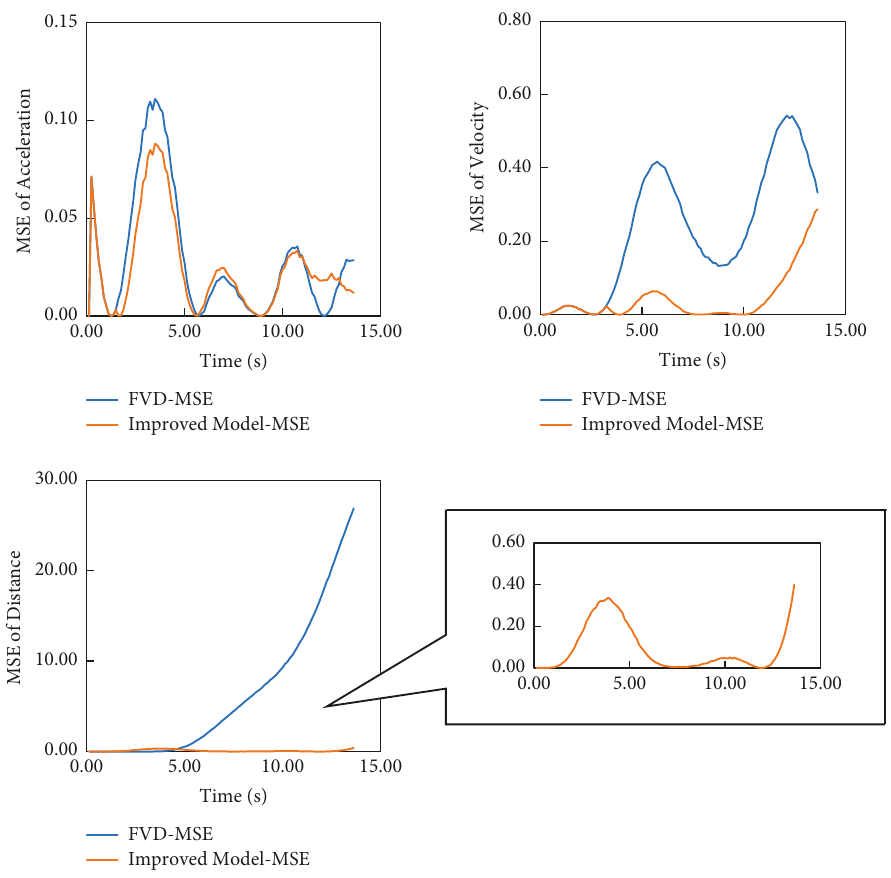
Figure 12: The curves of a subject vehicle’s acceleration, speed, and distance in a bus-car